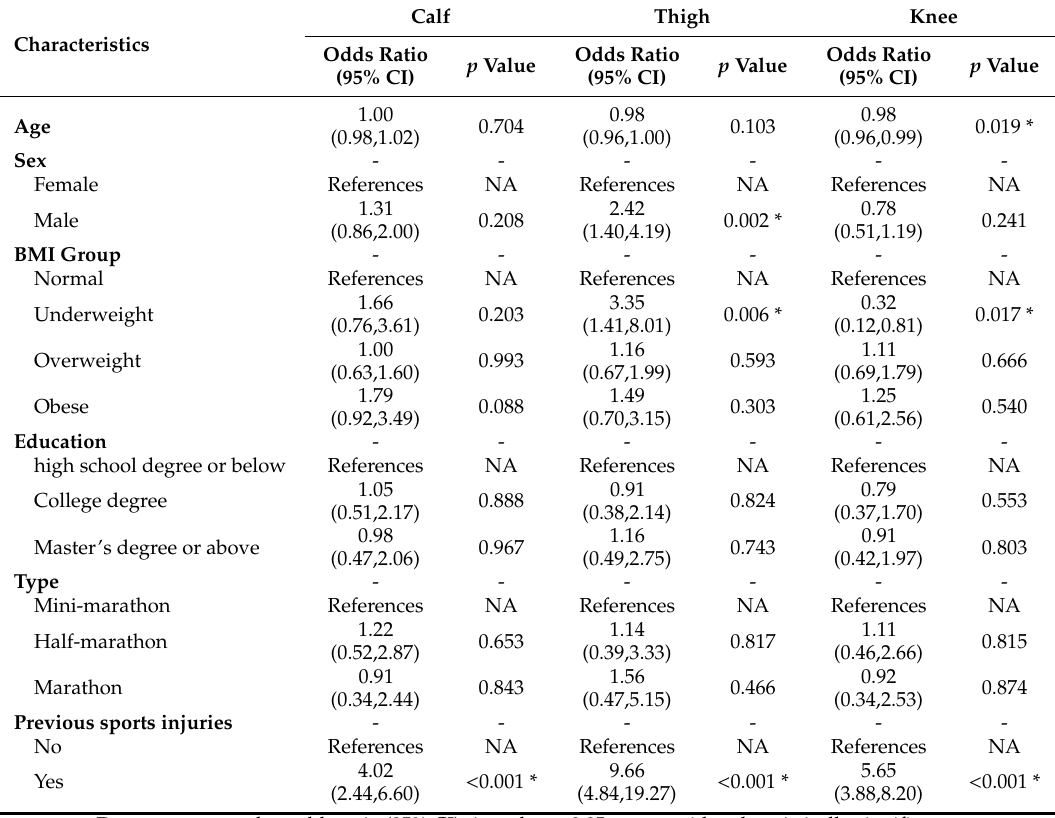
Table 2. Factors associated with injury (calf, thigh, and knee) in the lower extremities after the gorge marathon from 2013 to 2018 (n =